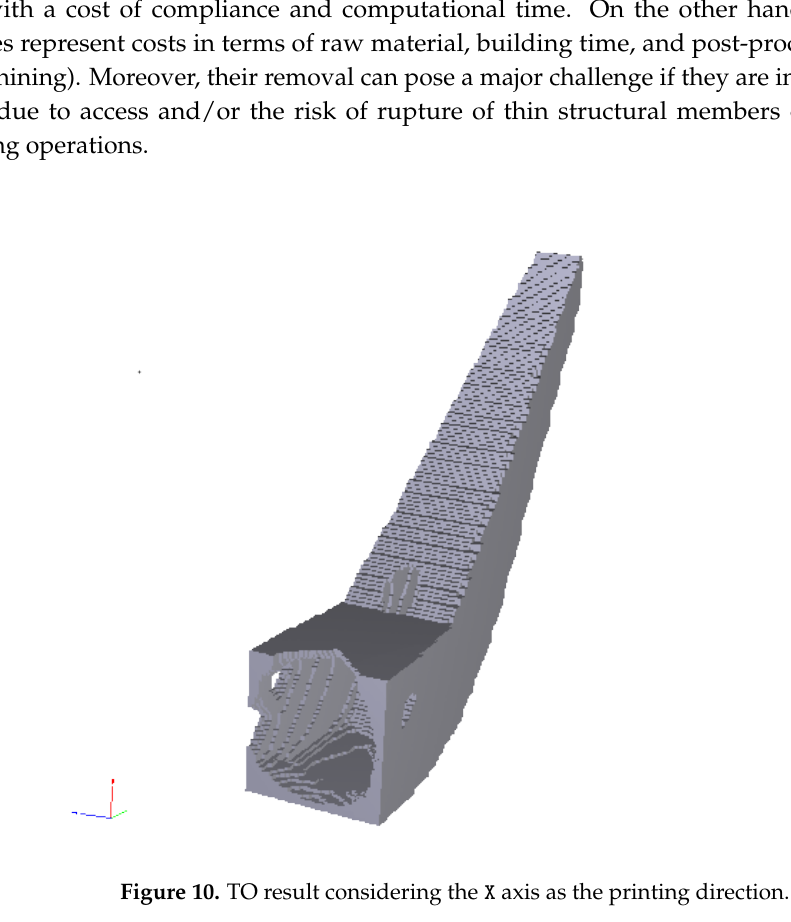
Figure 10. TO result considering the X axis as the printing